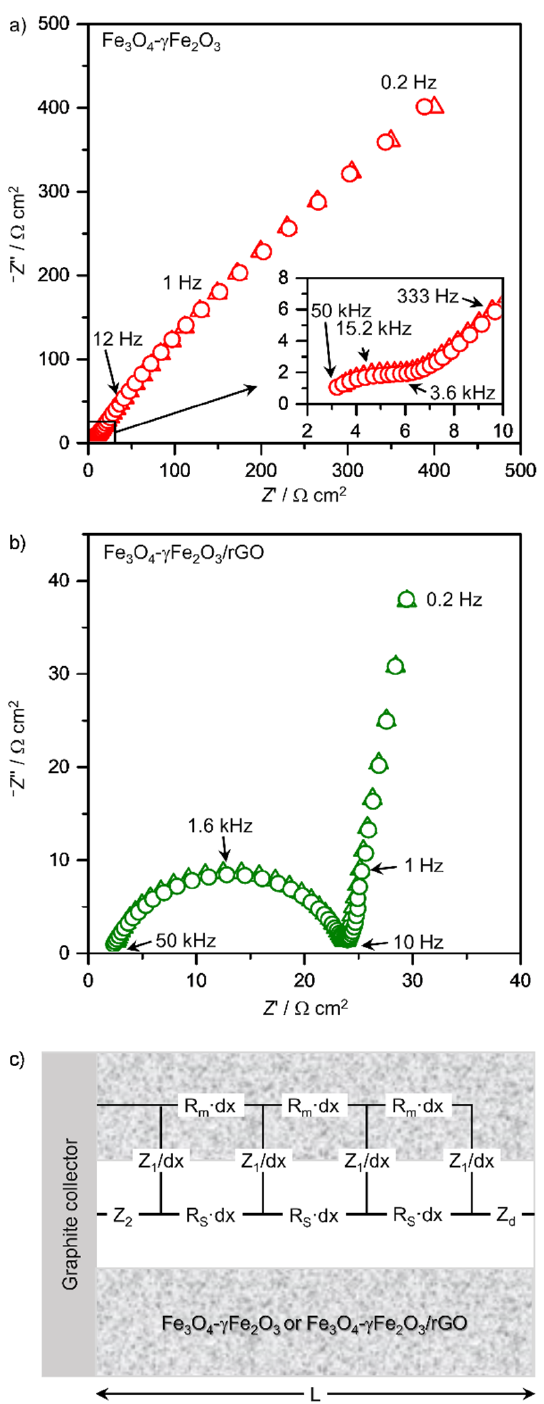
Figure 4. Nyquist impedance plots for ( a ) the clusters of Fe 3 O 4 - γ Fe 2 O 3 nanoparticles and the control sample Fe 3 O 4 - γ Fe 2 O 3 /rGO-C and ( b ) Fe 3 O 4 - γ Fe 2 O 3 /rGO hybrid material. ( c ) Electrical equivalent circuit employed to model the experimental EIS data.